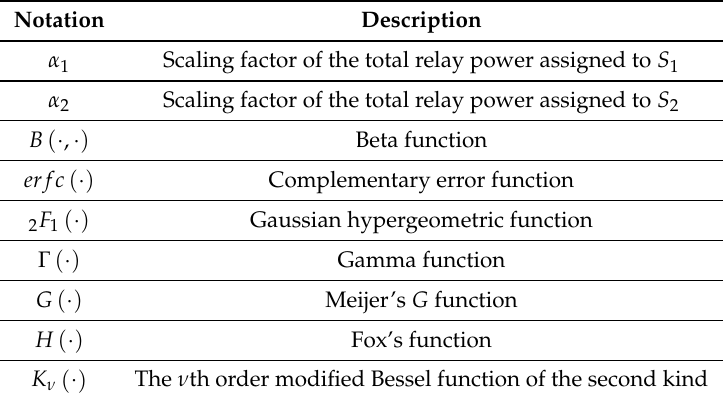
Table 1. Mathematical notations.